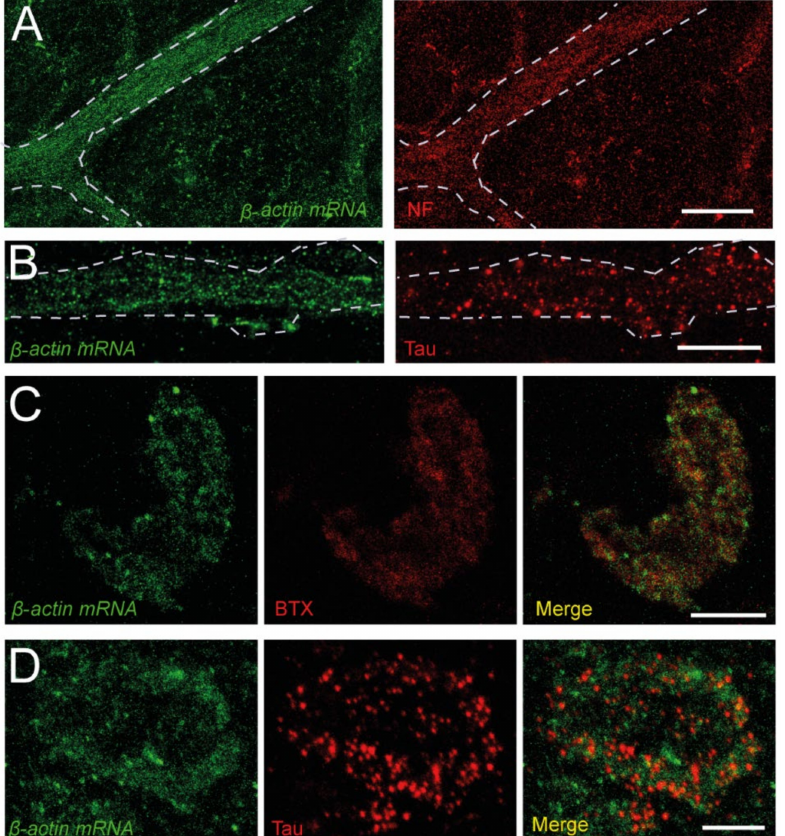
Figure 2. β -actin mRNA is present in peripheral axons and NMJs. ( A ). Example of β -actin mRNA (green) in a bundle of axons visualized by FISH (left panel). The same axons are marked with an anti-NF antibody (red, right panel). ( B ). Detail of the dotted signal of the probe in a band of axons (left panel), identified by its immunoreactivity to Tau (red, right panel). ( C ). Images of an NMJ displaying β -actin mRNA (green, left panel) and BTX (red, middle panel), and a merged image (right panel) ( D ). Images of an NMJ displaying β -actin mRNA (green, left panel) and Tau (red, middle panel) signals, and a merged image (right panel). Calibration bars: ( A ) 40 µ m, ( B – D ) 10 µ